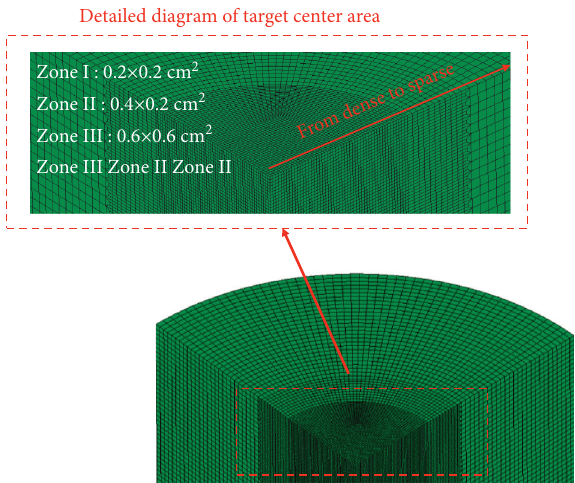
Figure 8: Finite element models of the concrete